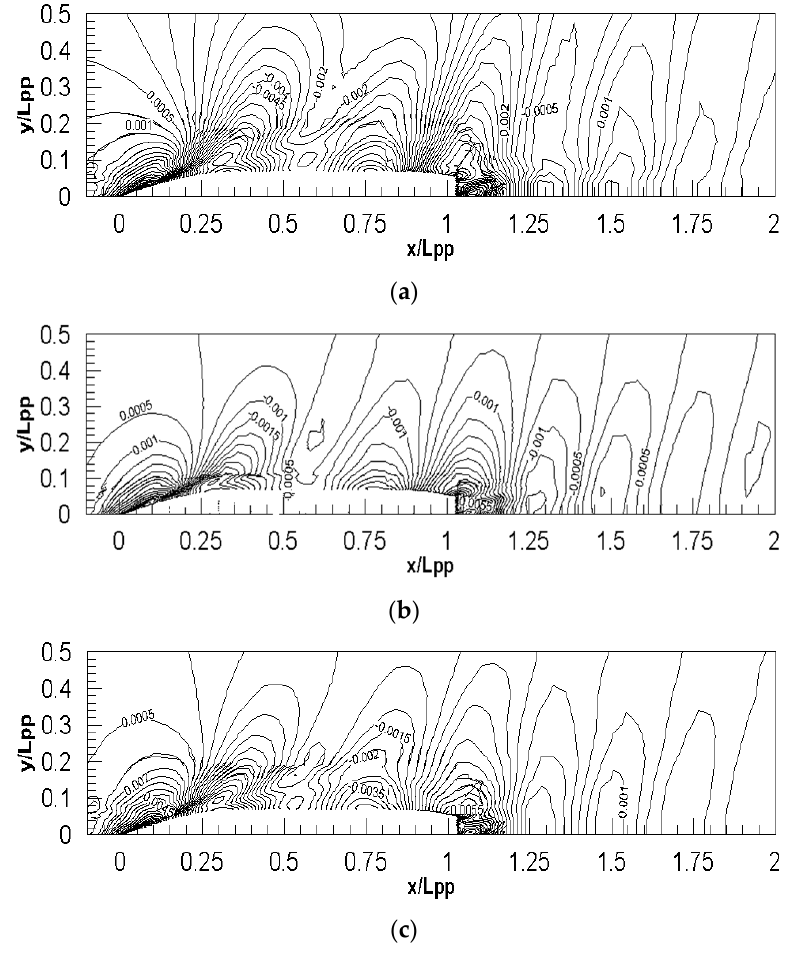
Figure 19. The wave patterns of full-scale simulations for different Froude depth numbers: ( a ) F nH = 0.66, ( b ) F nH = 0.47 and ( c ) F nH = 0.38.